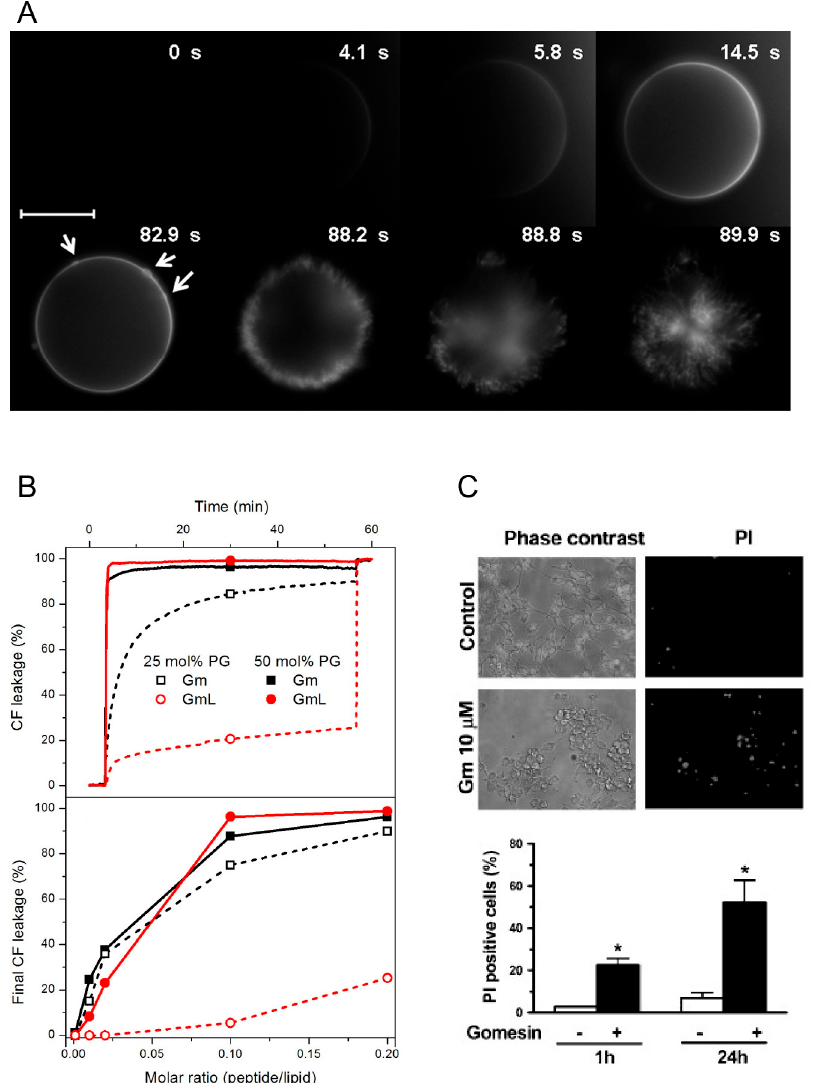
Figure 3. Leakage and permeabilisation activity of Gomesin (Gm). ( A ) Sequence of microscopy images for the injection of a fluorescently labelled Gomesin solution to a GUV composed of POPC/POPG (1:1). Arrows indicate the aggregation of peptide on the membrane surface. The scale bar is 20 μ m. Adapted with permission from Domingues et al. [27]. Copyright 2010 American Chemical Society; ( B ) Top panel: CF (5(6)-carboxyfluorescein) leakage from LUVs composed of POPC and 25 mol % or 50 mol % POPG. Bottom panel: Percentage of CF leakage as a function of peptide-lipid ratio. Images reprinted from Domingues et al. [26]. Copyright (2015), with permission from Elsevier; ( C ) Top panel: Effect of Gm on cell viability and permeabilisation of human SH-SY5Y cells. Photomicrographs taken with phase contrast (left) and fluorescence filter (right) to visualise cells stained with prodidium iodide (PI). Bottom panel: Histograms showing a quantitative analysis of PI-positive cells with (+) and without ( − ) treatment of Gm. Images adapted from Soletti et al. [17]. Copyright (2010), with permission from Elsevier.